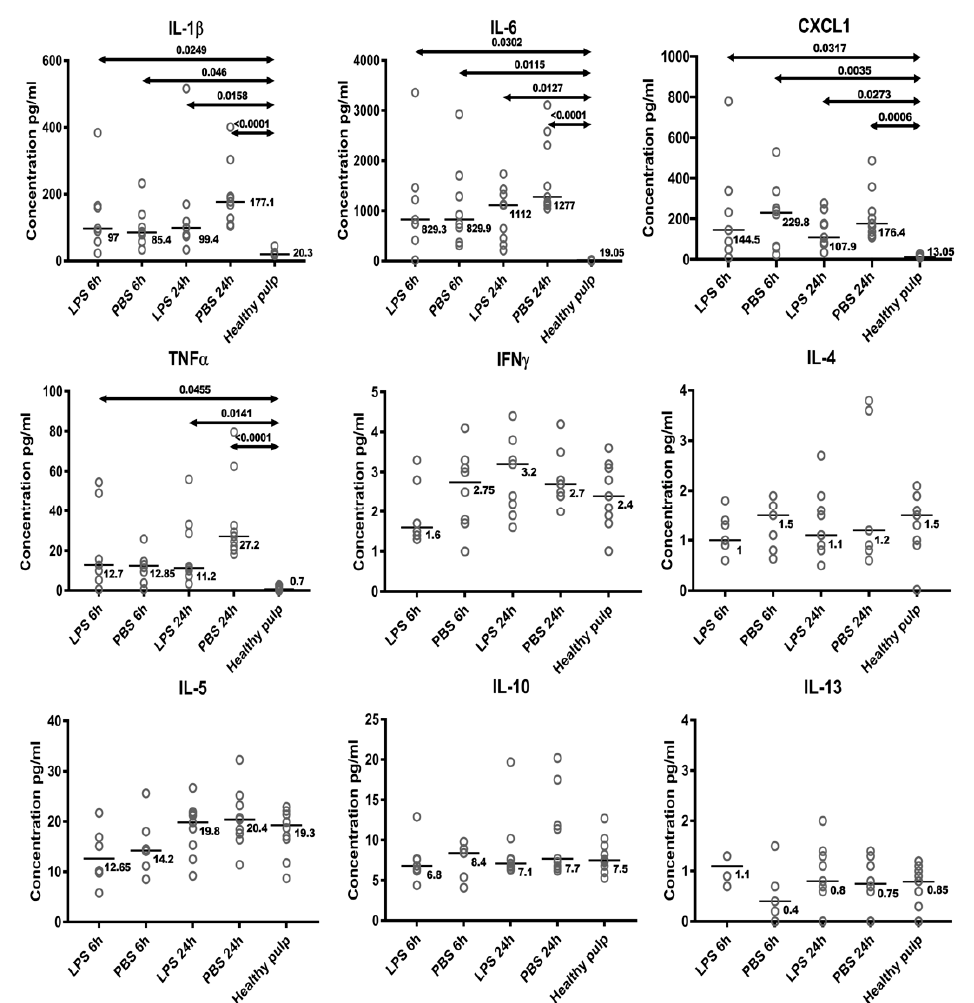
Figure 2. Analysis of expression levels of inflammatory proteins (interleukin-1 beta, -4, -5, -6, -10 and -13), chemokine ligand 1 (CXCL-1), tumor necrosis factor-alpha (TNF- α ) and interferon-gamma (IFN- γ ) in samples 6 or 24 h after phosphate-buffered saline (PBS) or lipopolysaccharide (LPS) treatment compared with levels in controls by enzyme-linked immunosorbent assay. Levels of IL-1 β , IL-6, TNF- α and CXCL-1 were up-regulated in all conditions compared with the control, while levels of IL-4, IL-5, IL-13 IL-10 and IFN- γ remained similar to those observed in the control. Kruskal–Wallis tests with Dunn’s tests were performed to compare all pairs of columns using GraphPad Prism version 6 (GraphPad Software, CA, USA); p -values (bold data highlight significant p -values).